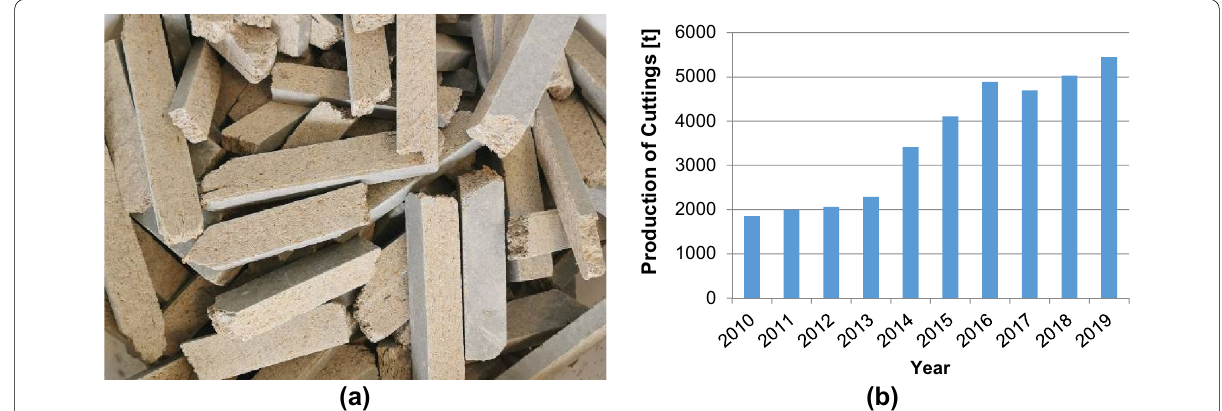
Fig. 3 Cuttings (by-product) from manufacture of cement-bonded particleboards: a sample taken in the manufacturing plant; b production of cuttings by CIDEM Hranice a.s. in the years 2010 to 2019